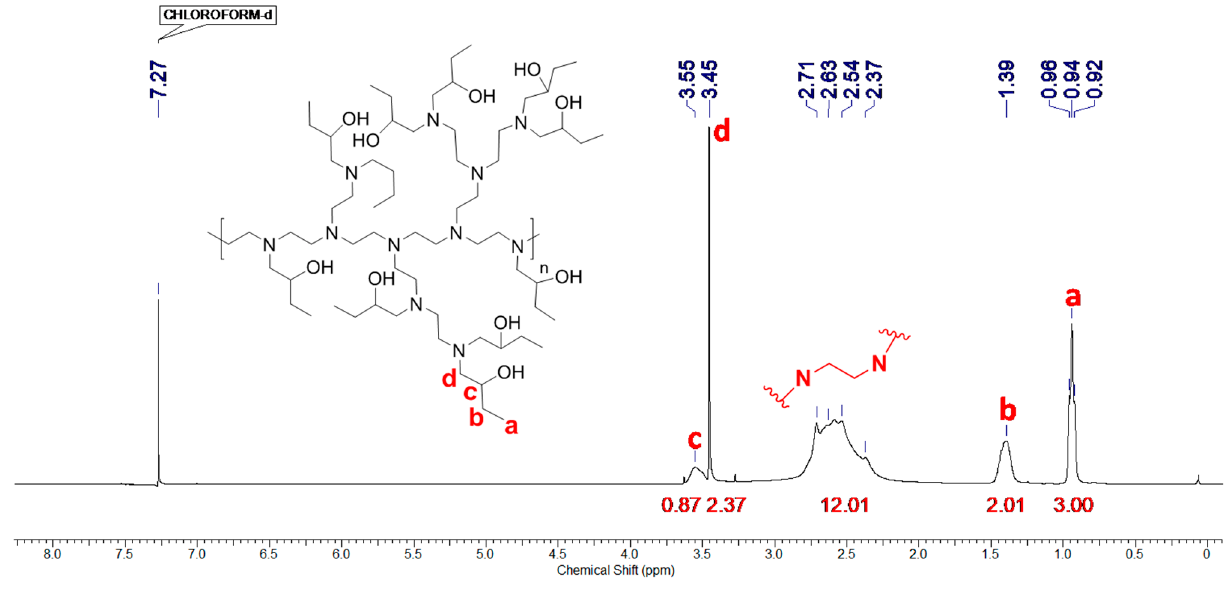
Figure 2. 1 H-NMR (400 MHz) spectrum of EB-PEI in CDCl 3 .